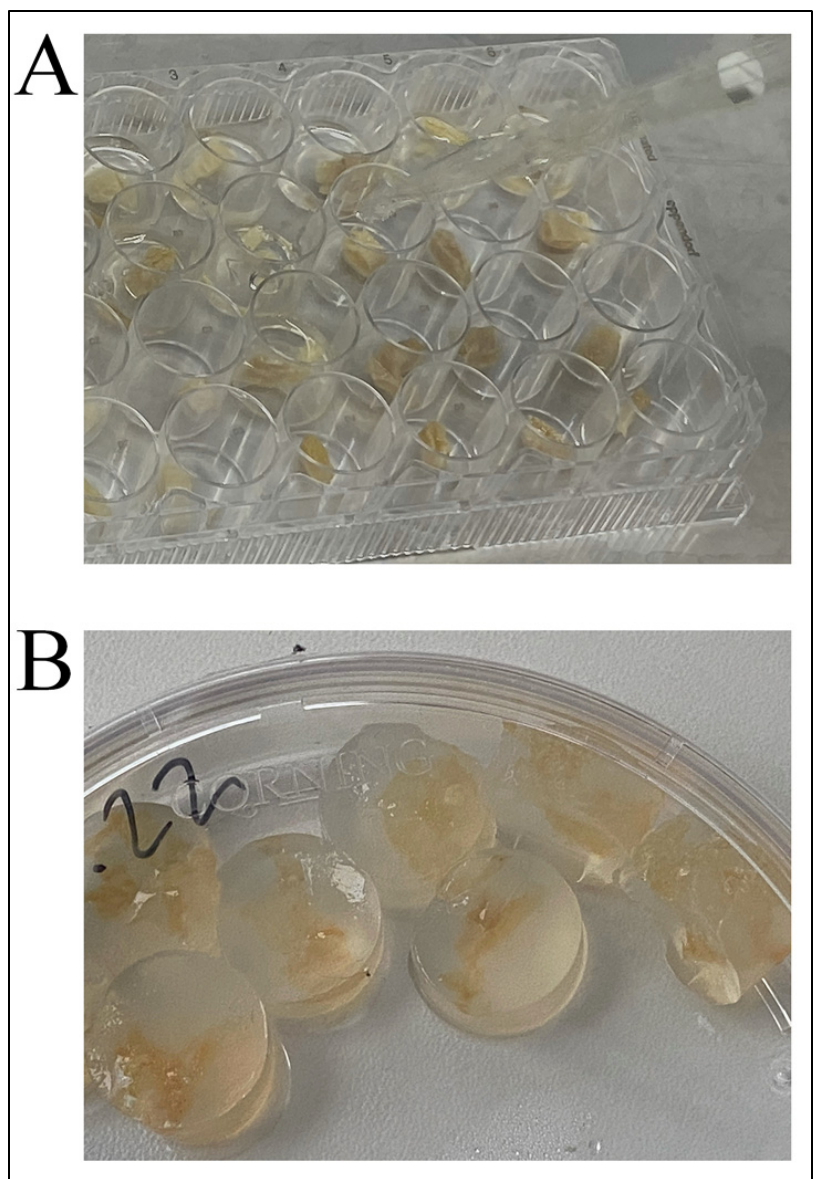
Figure 4. Overview of bacteria-loaded gel samples encapsulated in agar. ( A ). Preparation of gel–agar complexes; ( B ). Final solidified gel–agar complexes.